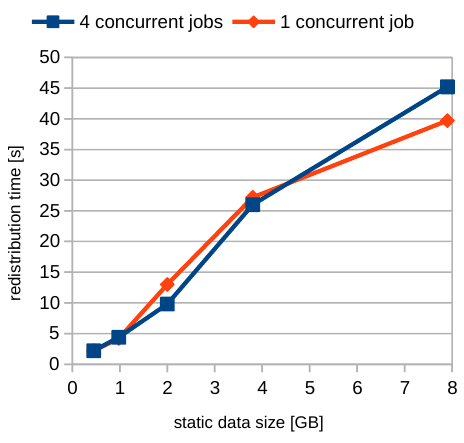
Figure 8. Redistribution time against static data size for the sPS